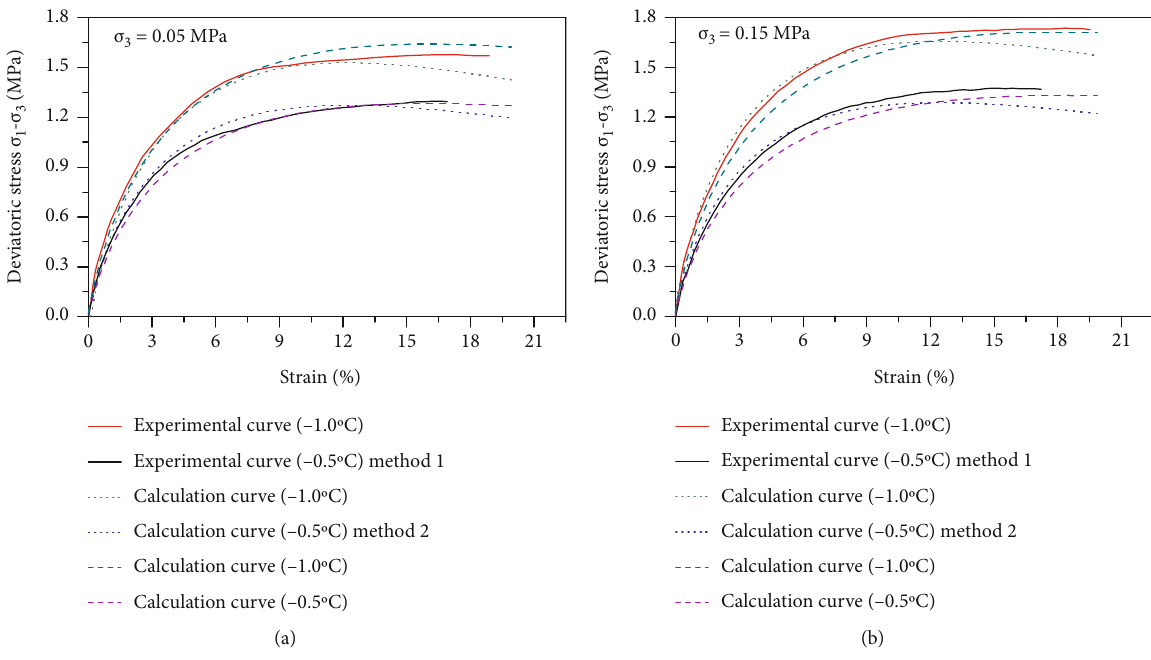
Figure 7: Comparison of the calculated values of the -0.3 ° C and -1 ° C damage models when -2 ° C is the nondestructive